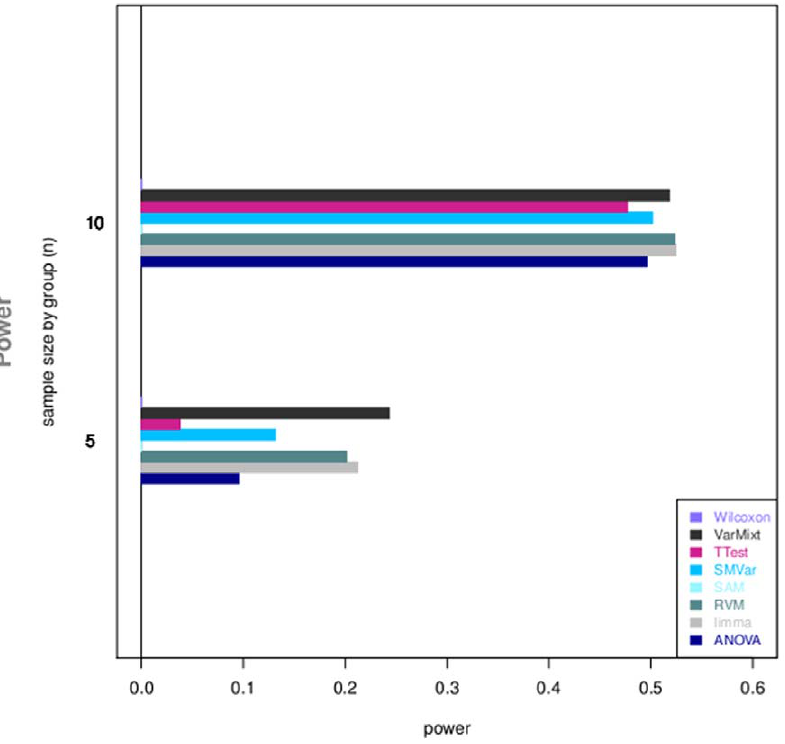
Figure 5. Re-sampling approach. Power values are calculated at a 0.1 FDR level and displayed according to the sample size.